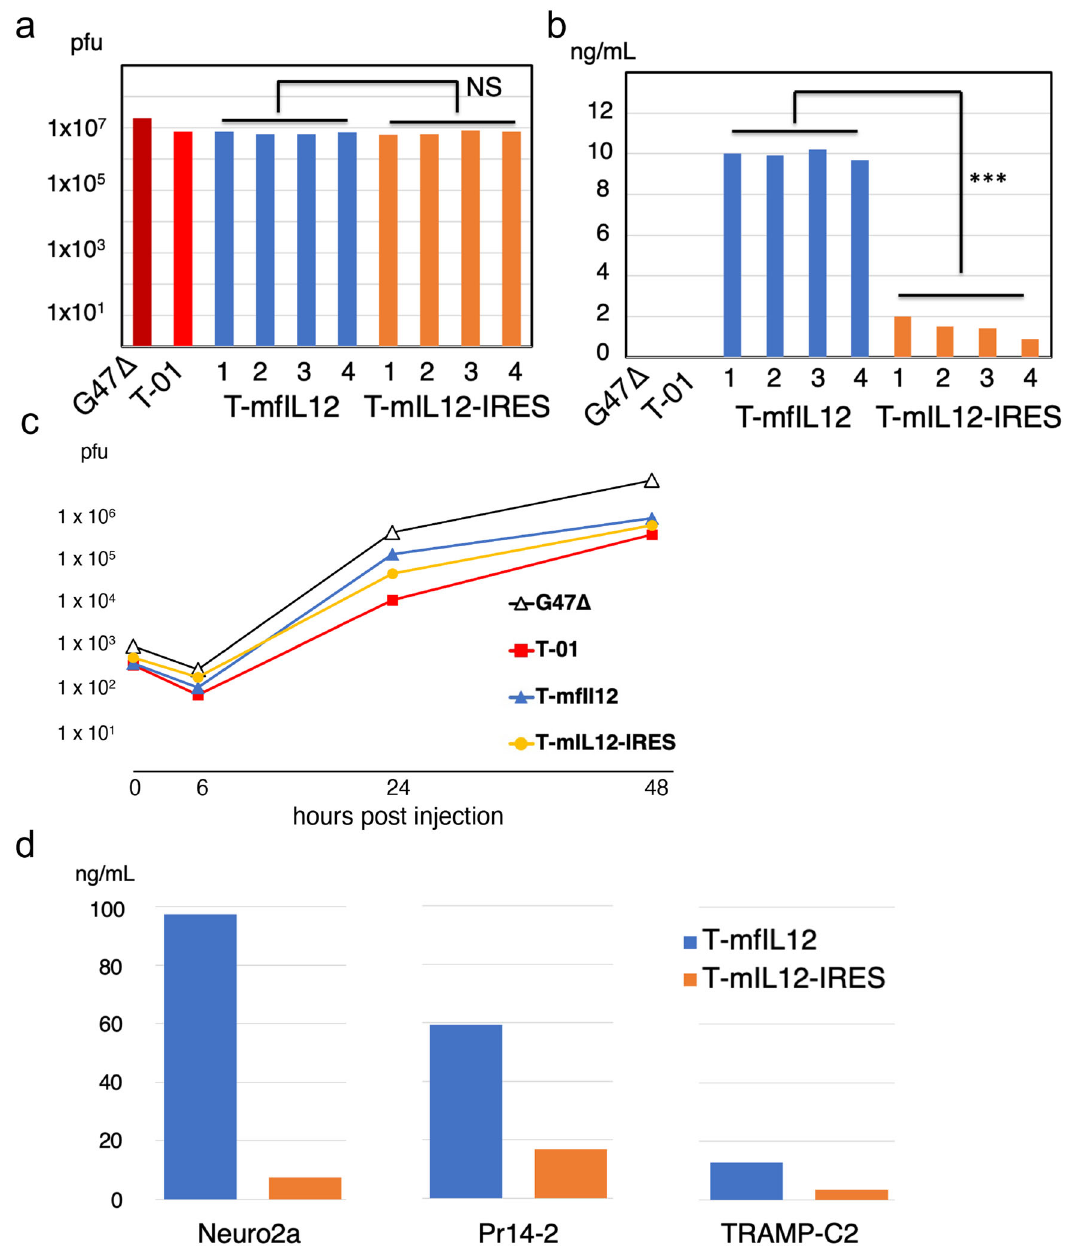
Fig. 2 In vitro replication capabilities and murine IL-12 expressions of T-mfIL12 and T-mIL12-IRES. a In vitro replication assay. Vero cells were